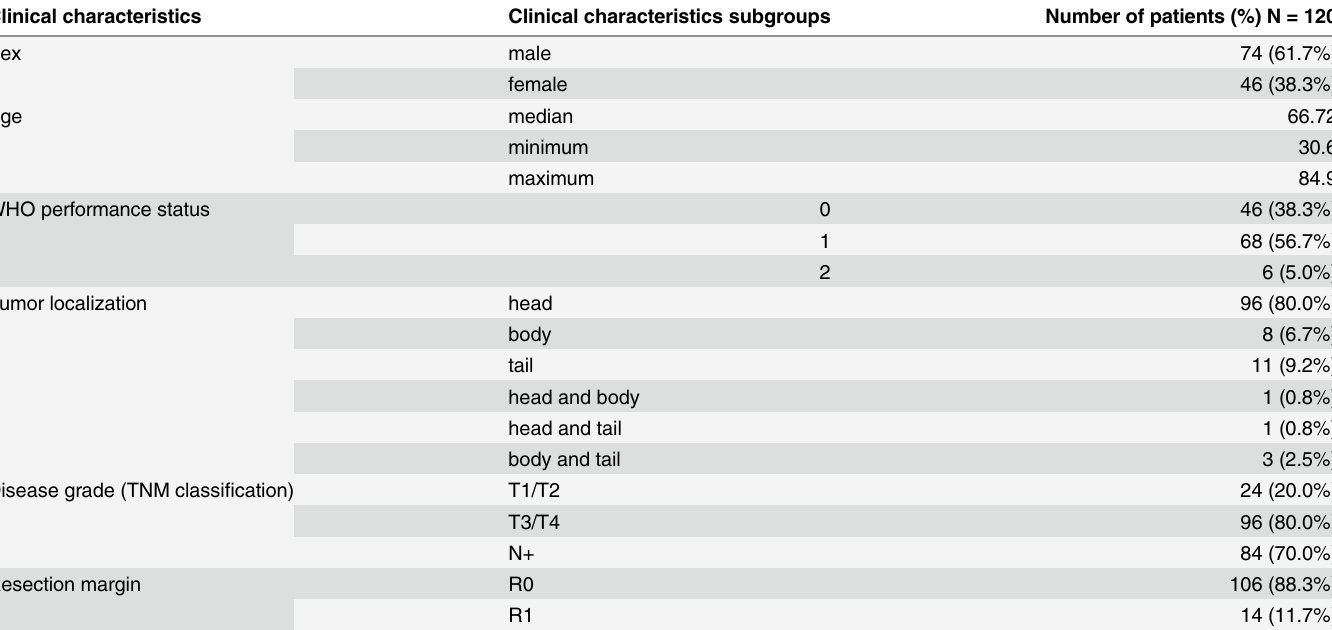
Table 1. Patients ’